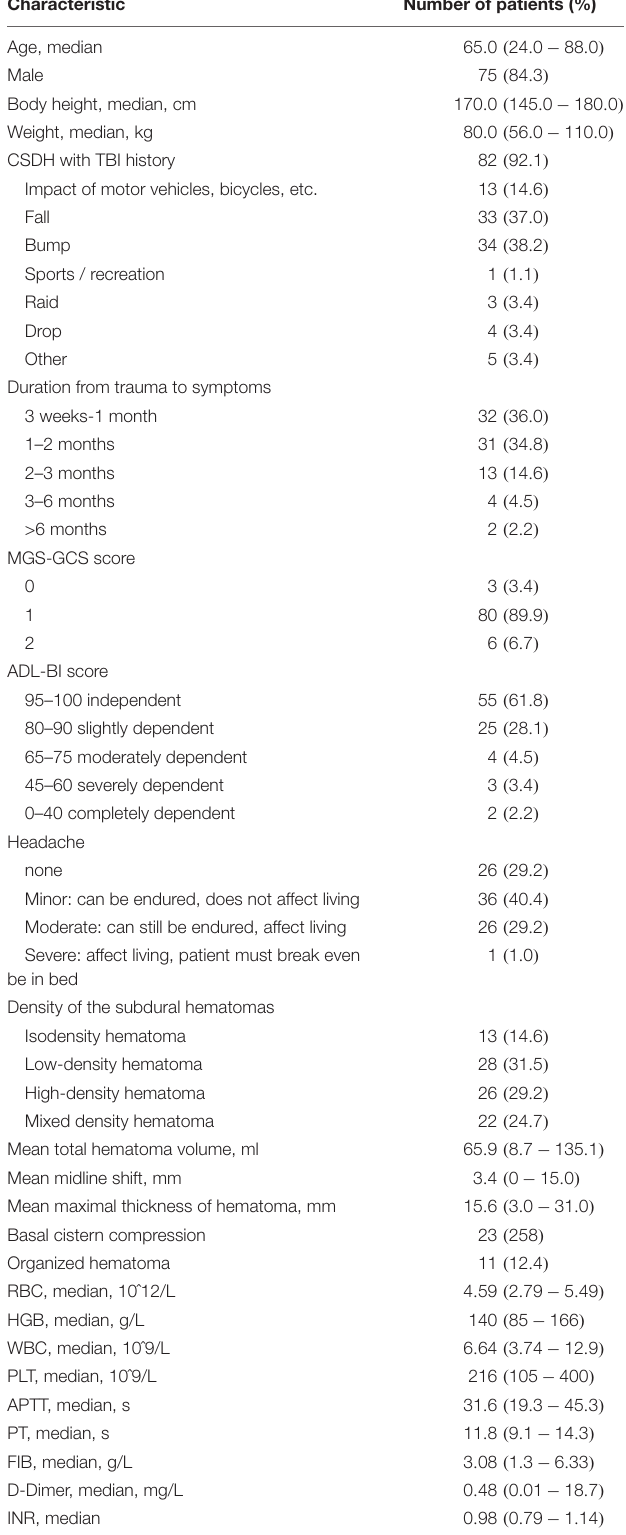
TABLE 2 | Baseline characteristics of patients with CSDH enrolled in the study.